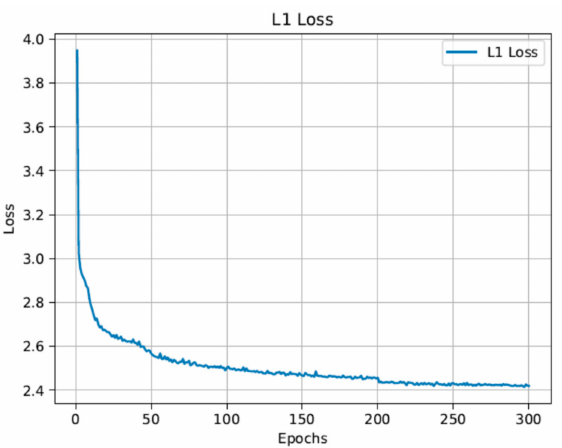
Figure 11. The loss plot of the training for 300 epochs.